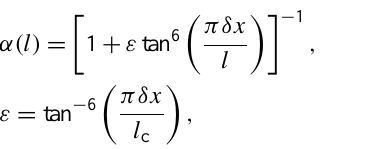
Figure 1. Amplitude responses for the Raymond filter as a function of wavelength with cut-off wavelength (a) 1200km, and (b) 600km. The GFS and WRF are demonstrated as a host model and a nested model,